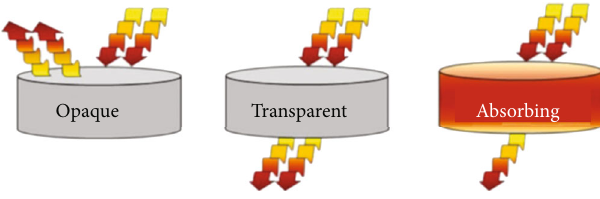
Figure 3: Macroscopic aspect of the microwave/matter